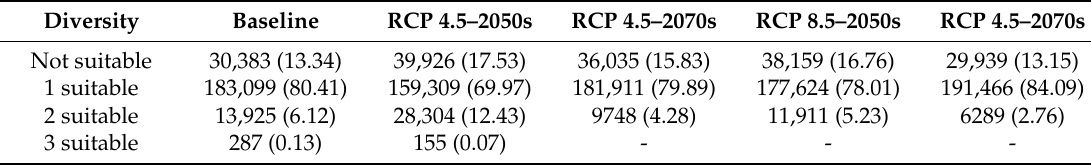
Table 2. Habitat diverse area statistics of each type and period, km 2